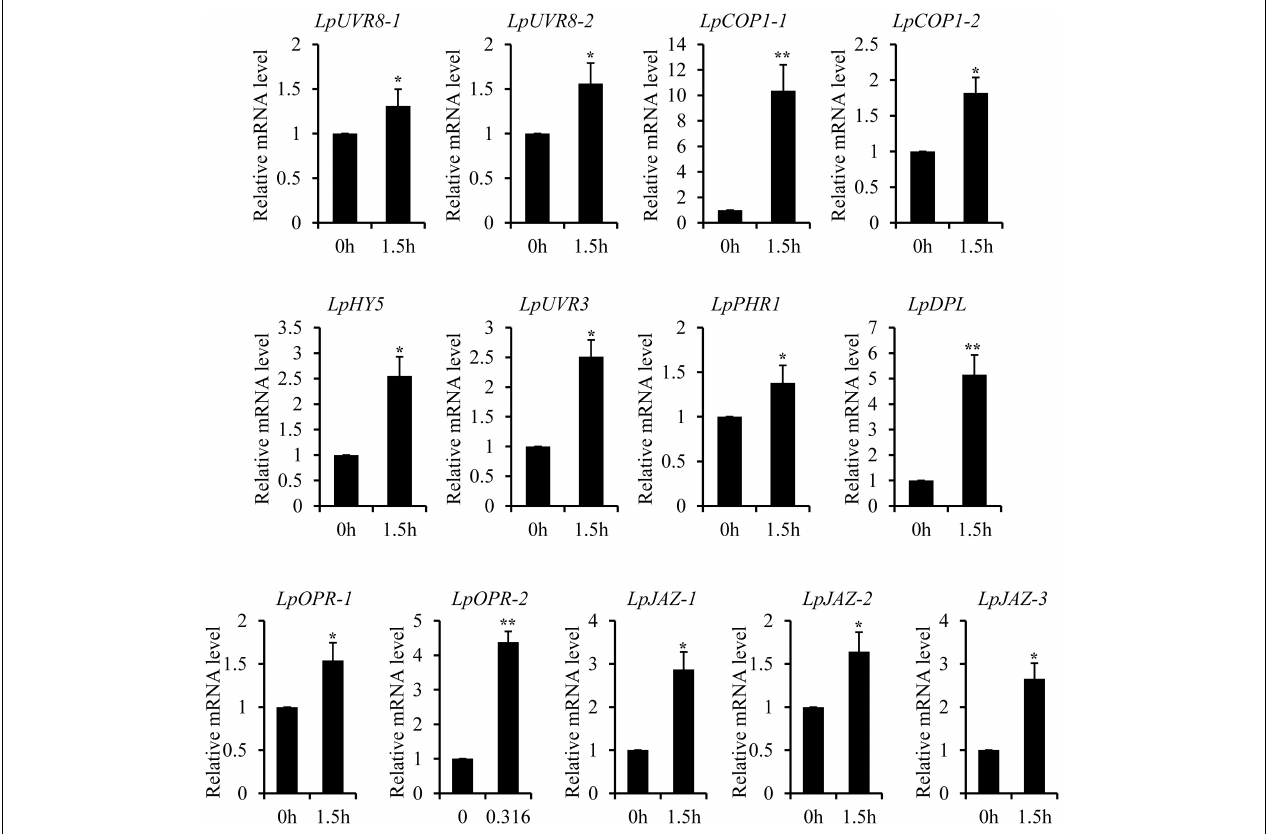
FIGURE 7 | Key genes of UVR8 and Jasmonate signaling pathway were up-regulated after UV-B treatment. The gene expression levels were analyzed by quantitative RT-PCR analysis; the Y-axis indicates the relative expression level; the X-axis indicates UV-B treatment time (h); The data were calculated from three biological replicates. Vertical bars are means ± SE. Significant difference (* P < 0.05, ** P <